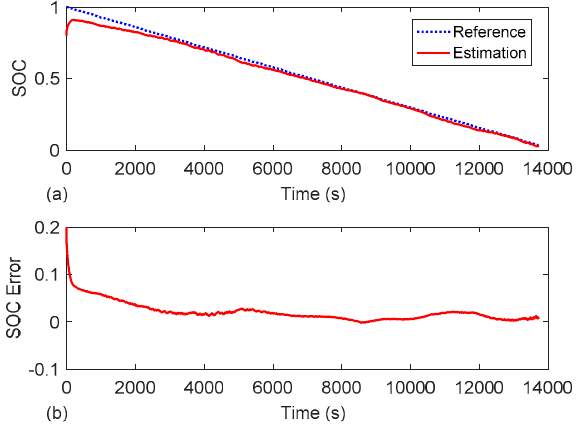
Figure 8. SOC estimation result with 20% initial error under FUDS schedule: ( a ) SOC; ( b ) SOC error.